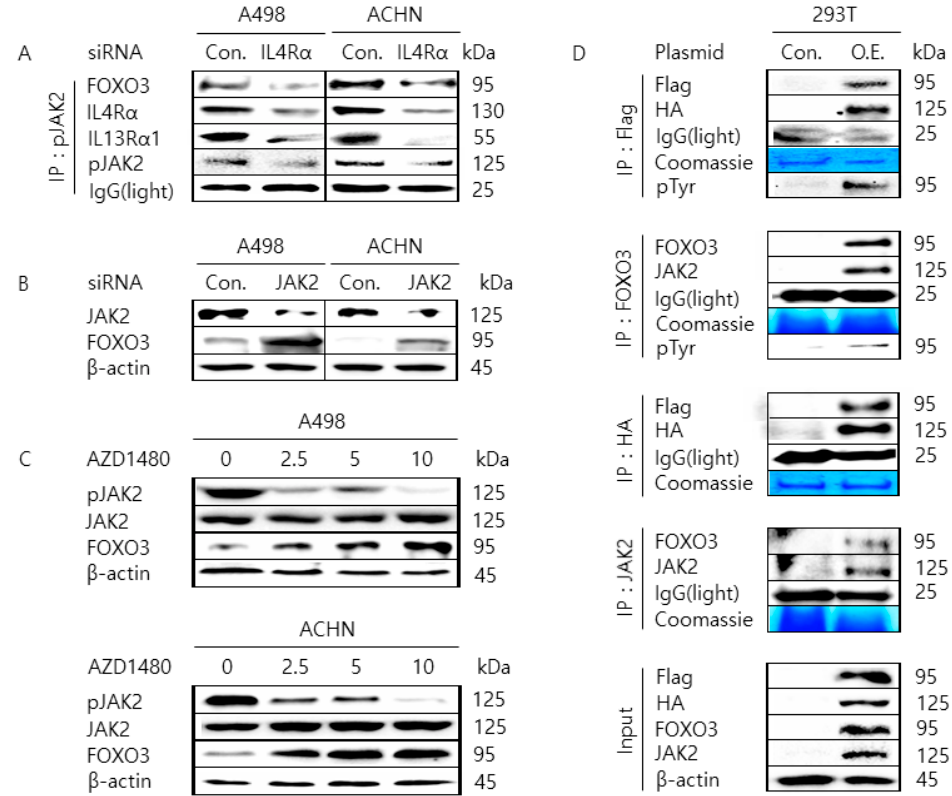
Figure 3. Interaction between Janus kinase 2 (JAK2) and Forkhead box O3 (FOXO3) protein in A498 and ACHN. ( A ) Silencing IL4R α in A498 and ACHN cells reduced the interaction between JAK2 and FOXO3. Cells were transfected with control siRNA or siRNA against IL4R α , and then cell lysates were immunoprecipitated with the anti-pJAK2 antibody. The immunoprecipitated proteins were resolved on the sodium dodecyl sulfate polyacrylamide gel electrophoresis (SDS-PAGE) and immunoblotted by anti-IL4R α , IL13R α 1, FOXO3, and pJAK2 antibody. The light chain of IgG was used for the loading control. ( B ) 293T cells were co-transfected with HA- JAK2 and Flag-FOXO3 (O.E.) or a control plasmid DNA (pCMV3-C-HA and pECE, Con.) as indicated. Then cell lysates were immunoprecipitated with anti-Flag, FOXO3, HA, JAK2, or pTyr antibody. The immunoprecipitated proteins were resolved on